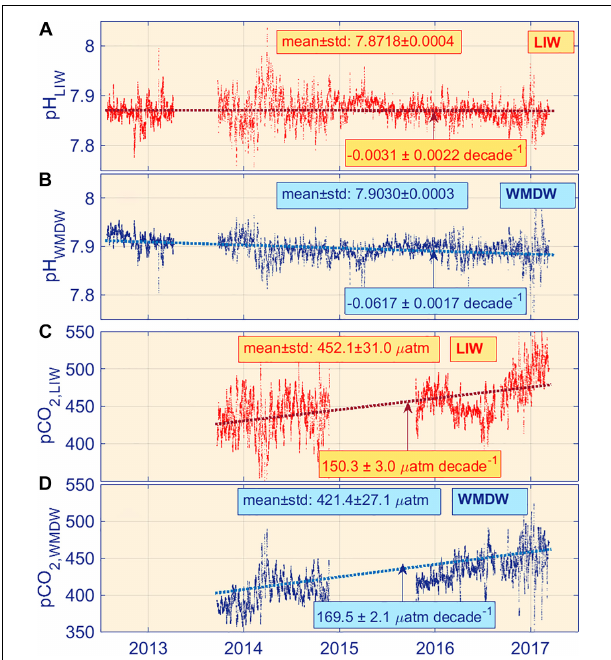
FIGURE 10 | (A) and (B) . Time series of pH T 25 assigned to LIW and WMDW, respectively, applying the water masses fraction analysis specified in Section “Fraction Composition of the Outflow.” (C) and (D) Idem for pCO 2